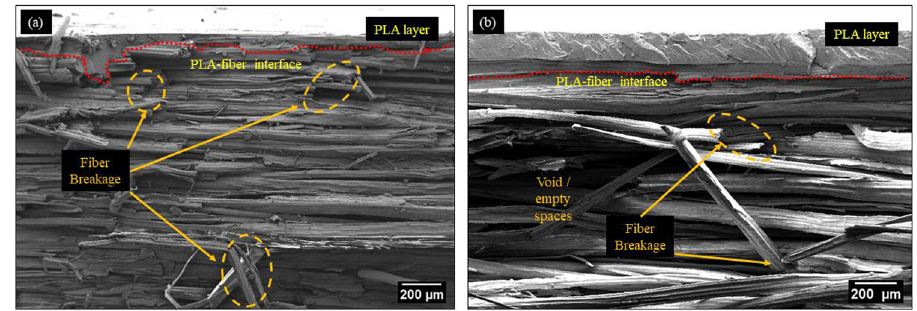
Figure 11: SEM micrographs of the tensile fractures of PLA – kenaf fi ber composites with fi ber orientations of ( a ) 45° and ( b )